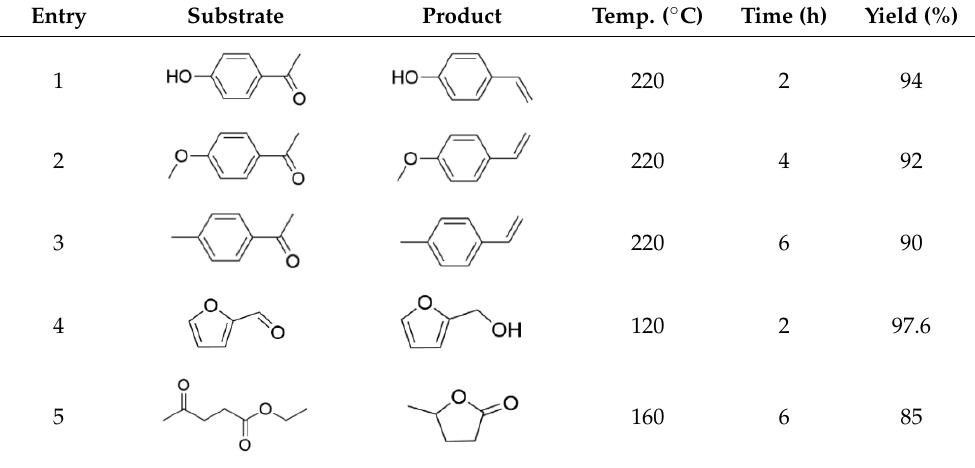
Table 3. PhP-Hf (1:1.5) catalyst expands the substrate of carbonyl compounds. Entry Substrate Product